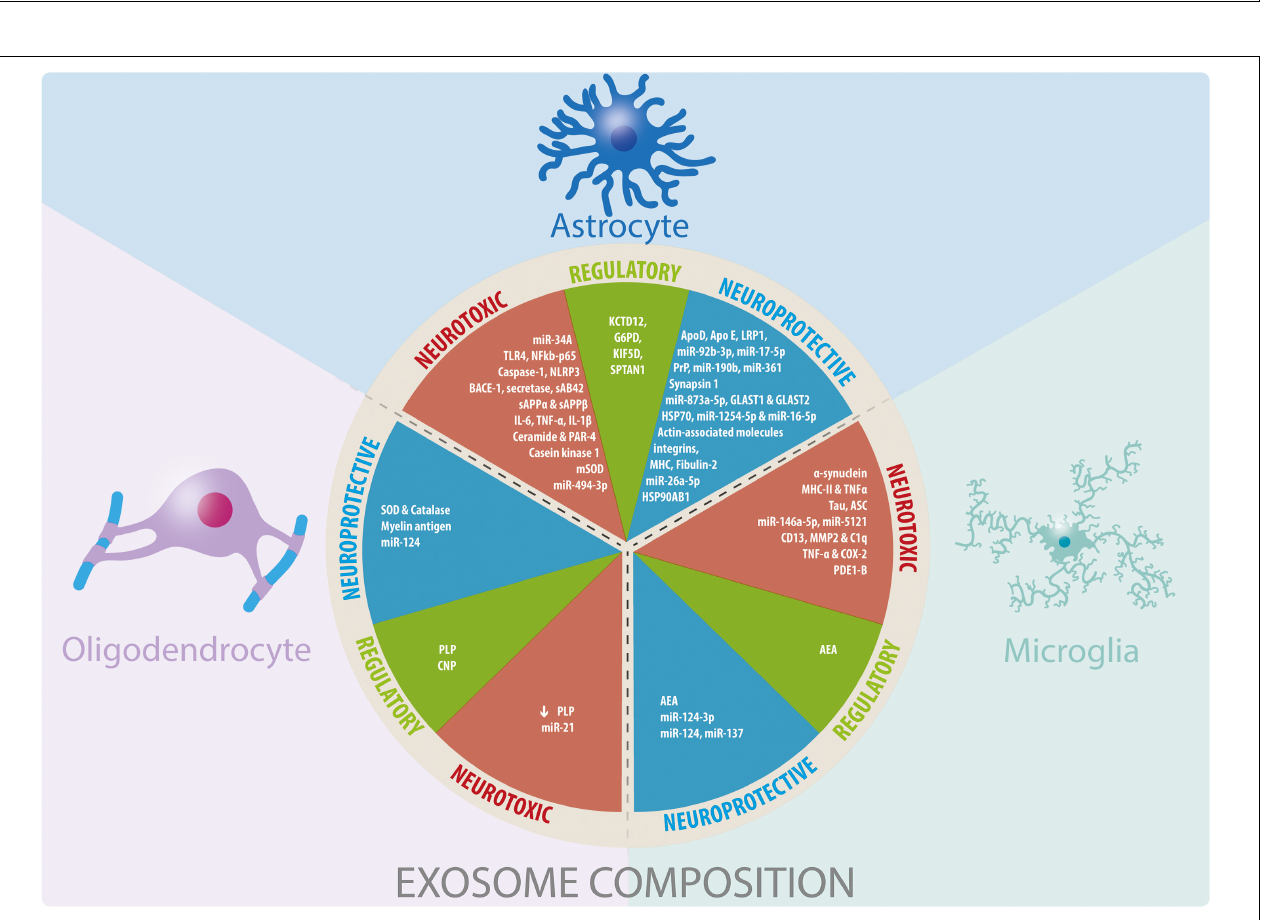
FIGURE 2 | Glial cells-derived exosomes coposition and their participation in neuroprotective, neurotoxic, and regulatory functions. Summary of the information reported about the cargo of exosomes derived from glial cells and their effects observed in different physiological and pathophysiological models in vitro and in vivo .